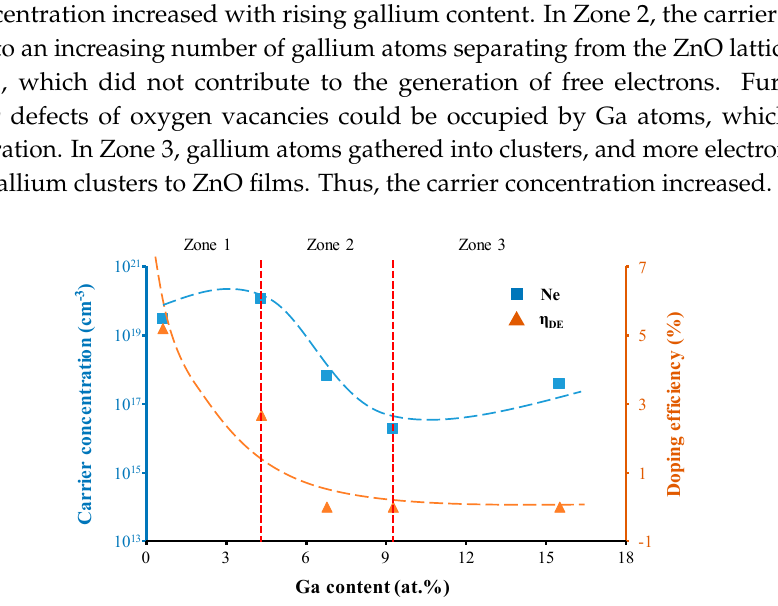
Figure 5. The variation in carrier concentration Ne and doping efficiency η DE as a function of Ga content (the bulk ZnO density of 5.606 g/cm 3 was used to estimate η DE ).